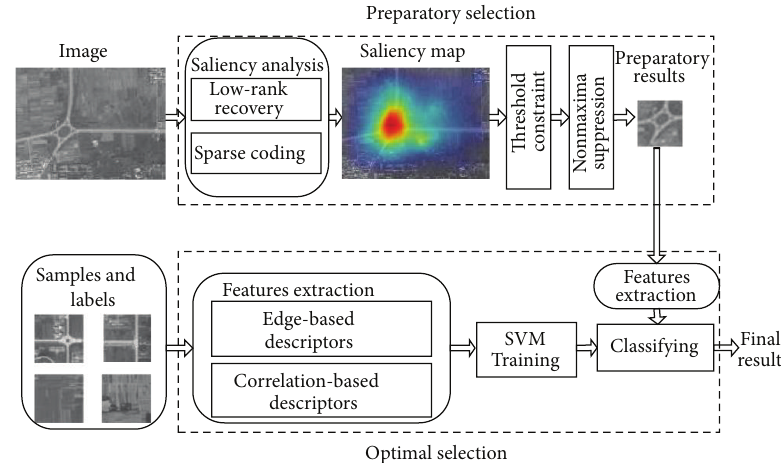
Figure 1: Framework of our proposed method.